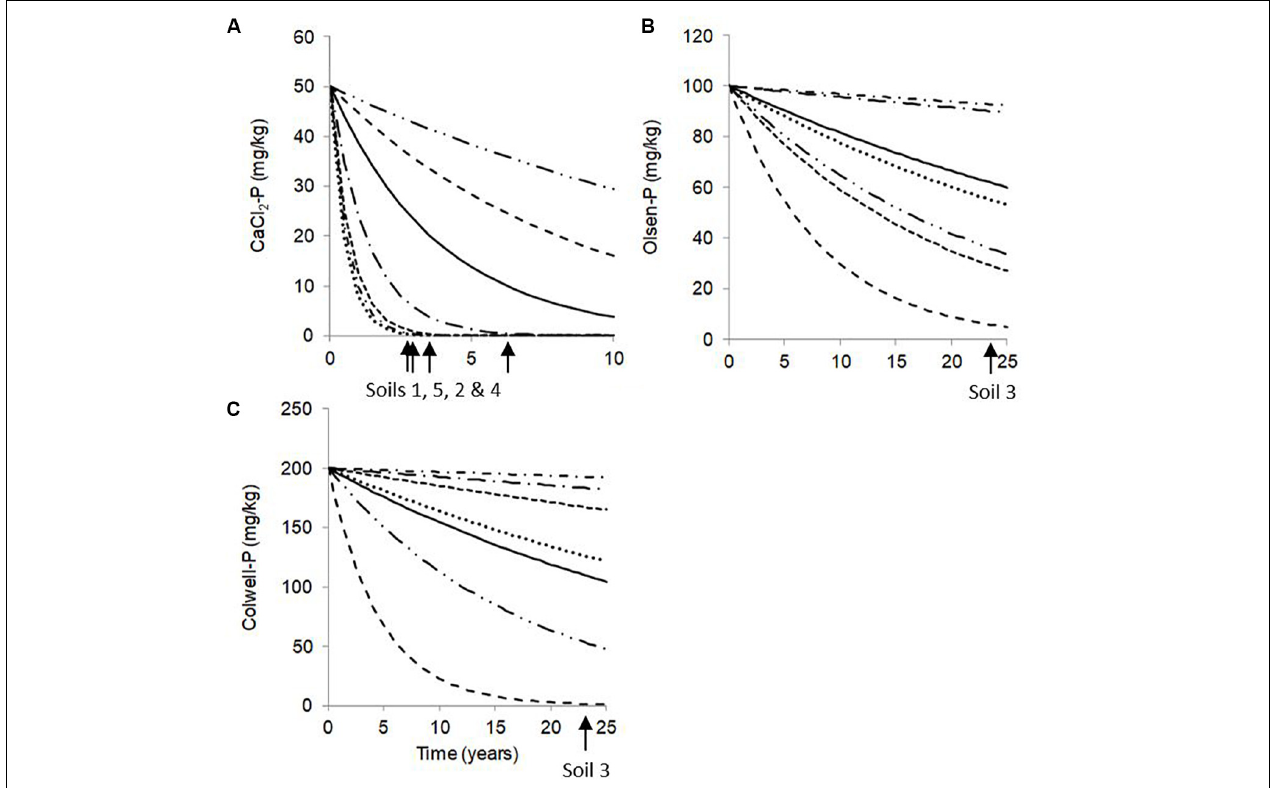
FIGURE 2 | Predicted (A) CaCl 2 -P, (B) Olsen-P, and (C) Colwell-P generic curves with zero P fert (solid lines) which used the global parameters across all soils ( d 0 ); and for Soil 1 ( ... ), Soil 2 (---), Soil 3 (––), Soil 4 (–.–), Soil 5 (-.-), and Soil 6 (–..–), using soil parameters ( d s ). Labelled arrows indicate the estimated time required for soils to reach environmental and agronomic thresholds. Note x- and y-axes are differently